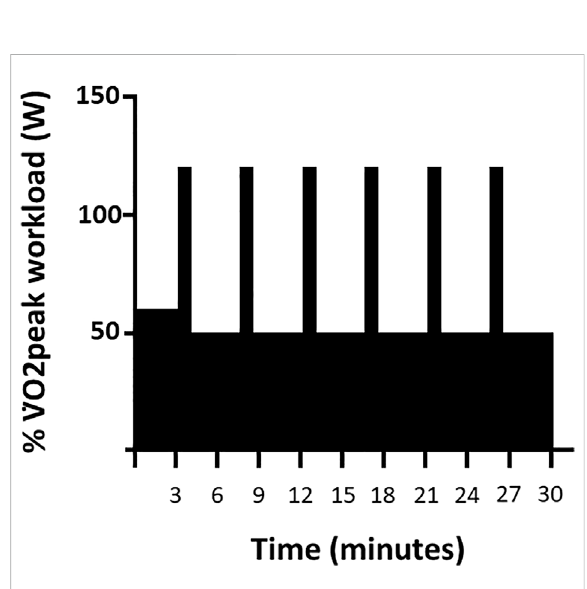
FIGURE 2 High-Intensity Interval Training. Timeline of a single 30-min HIIT session as a function of percent of V _ O2peak workload